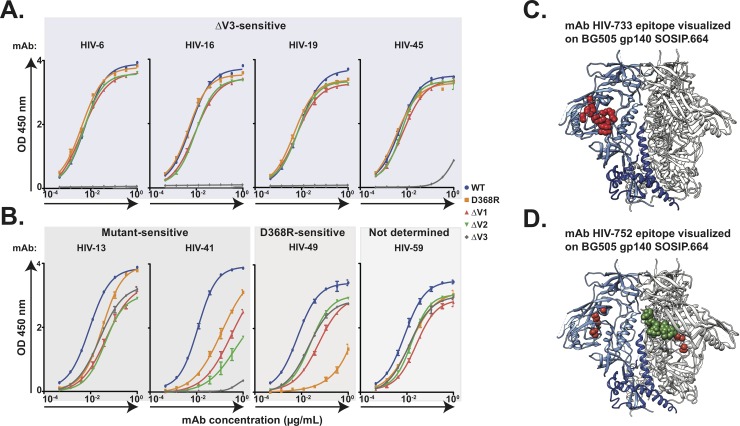
Epitope mapping neutralizing HIV-1 mAbs from subjects VC10014 and VC20013.ELISA was used to determine the epitopes of several HIV-1 NAbs by testing binding to SF162 wt Env, SF162 ΔV1, SF162 ΔV2, SF162 ΔV3, and SF162 D368R mutants. (A) Binding phenotype of V3-specific mAbs determined by ELISA. (B) Binding phenotype of CD4-specific mAbs determined by ELISA. Using a comprehensive library of HIV-1 Env mutants, cytometric flow sorting was used to identify critical residues for the binding of HIV-1 mAbs. (C) Visualization of mAb HIV-733 epitope (indicated in red) on the crystal structure of BG505 gp140 SOSIP.664. (D) Visualization of mAb HIV-752 epitope (indicated in red) and critical residues at the N262 glycosylation site (indicated in green) on the crystal structure of BG505 gp140 SOSIP.664.